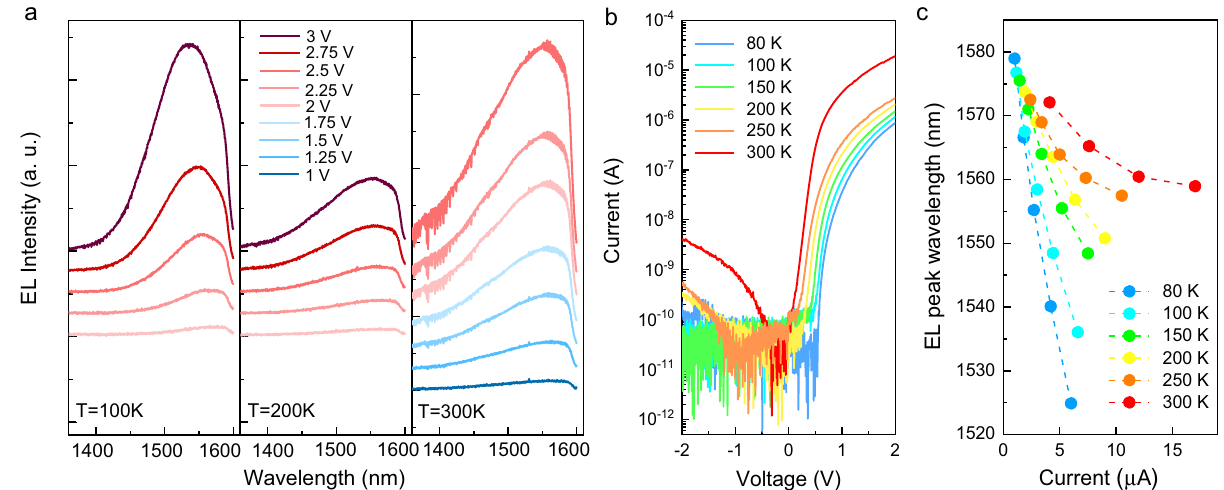
Fig. 4 Electrically pumped light emission. a Electroluminescence (EL) spectra of a 350 nm wide T-shape device (T3) under continuous wave (CW) operation, measured at 100 K, 200 K, and 300 K. b Current – voltage ( I – V ) curves measured from 80 K to 300 K. c EL peak wavelength dependence on injection current at various temperatures from 80 K to 300 K. EL spectra and peak energy plots in photon energy can be found in Supplementary Fig. 5.